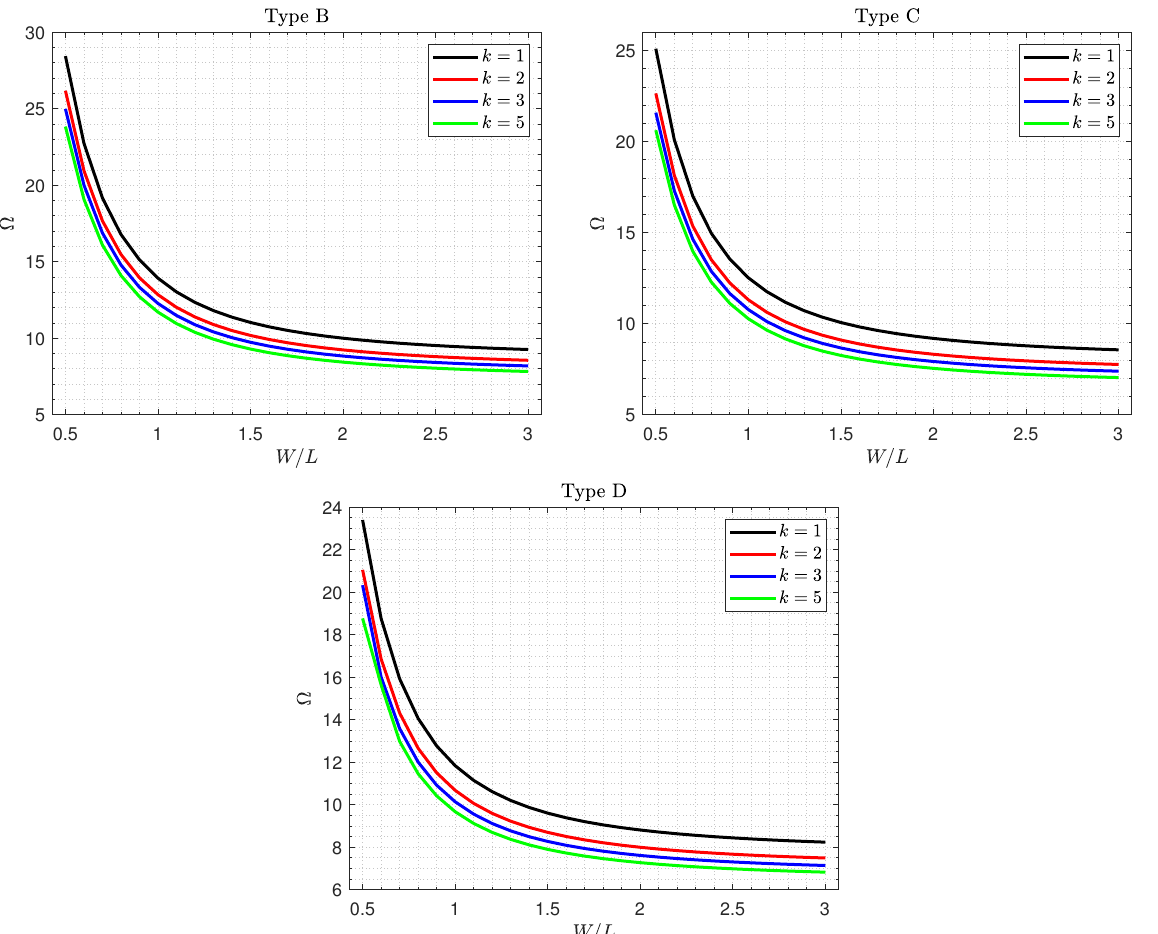
Figure 6. Effects of the power-law index k on the frequency of different types of the nanocomposite piezoelectromagnetic plate.